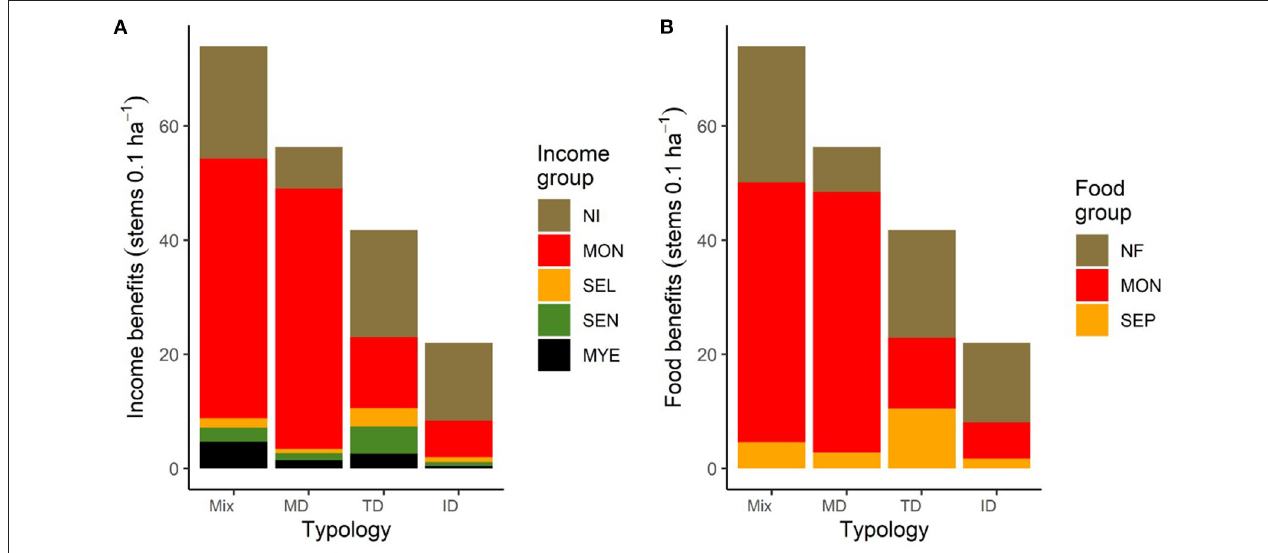
FIGURE 5 | Average income (A) and food types (B) from the agroforestry system types. Income (NI, no income; MON, monthly; SEL, seasonal local; SEN, seasonal national; MYE, Multiyear) and Food (NF, no food; MON, monthly; SEP, seasonal perishable). Categories absent from the graph are seasonable storable food and emergency or famine